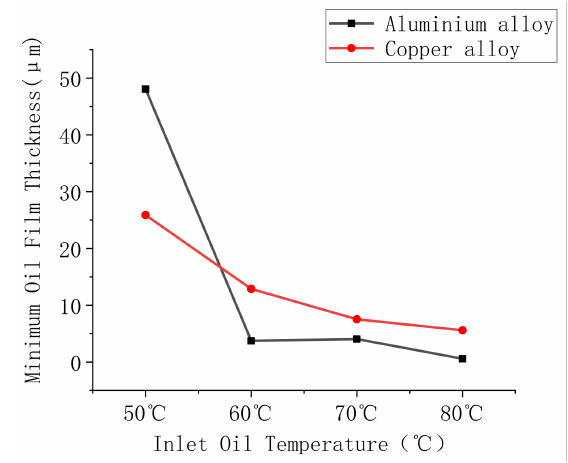
Figure 8. Curves of minimum oil film thickness of the two